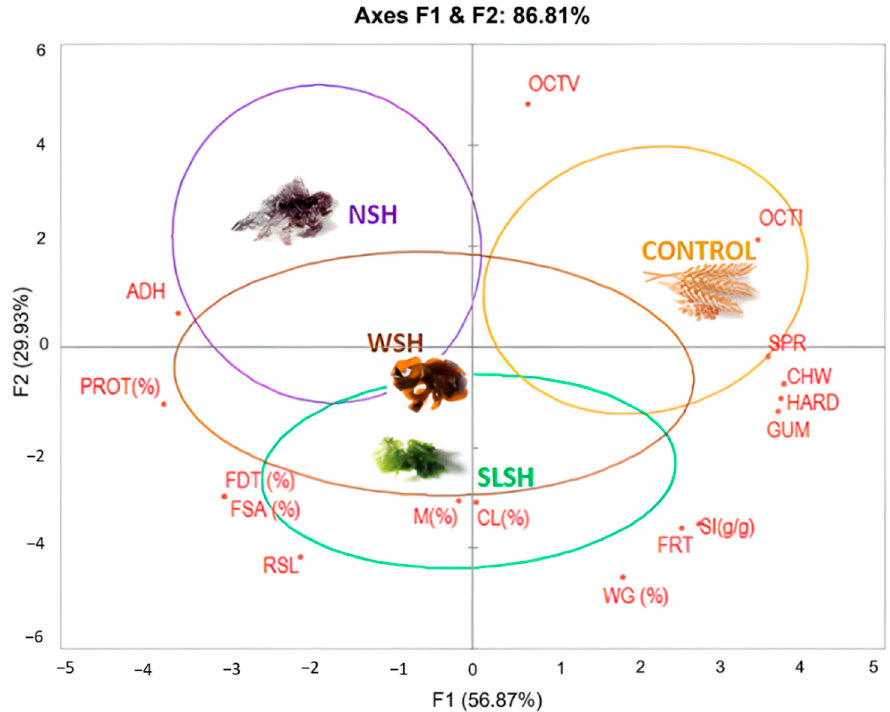
Figure 4. Principal Component Analysis, PCA, from TPA and technological property results in